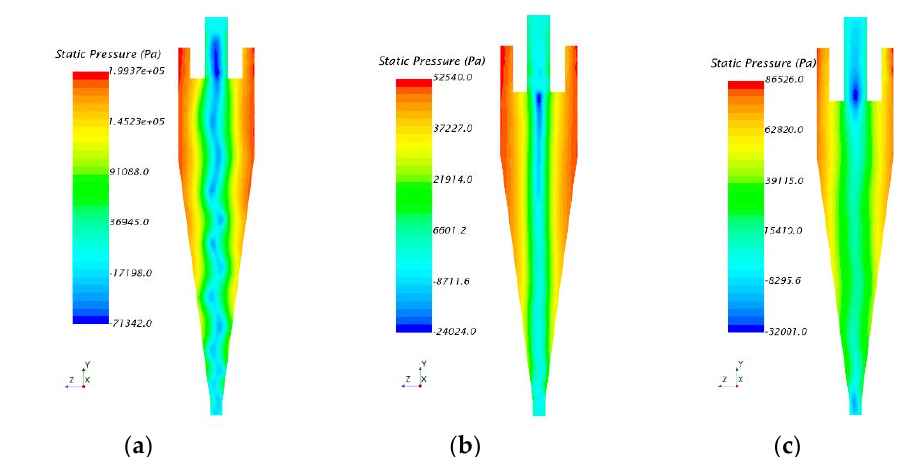
Figure 9. Static pressure at 60 s at an inlet feed velocity of 10 m/s ( a ) VF = 20 mm ( b ) VF= 30 mm ( c ) VF = 35